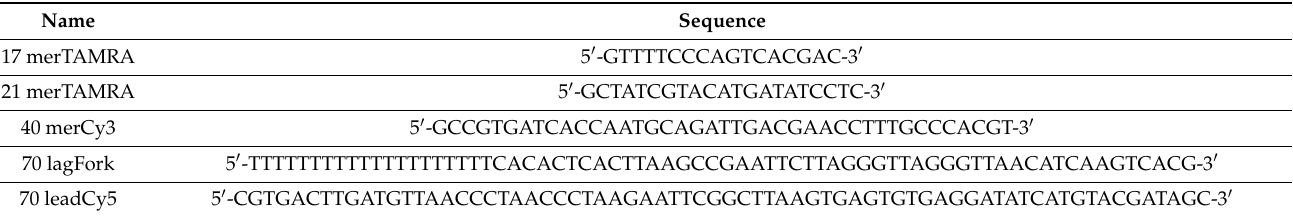
Table 1. Oligonucleotides used for the